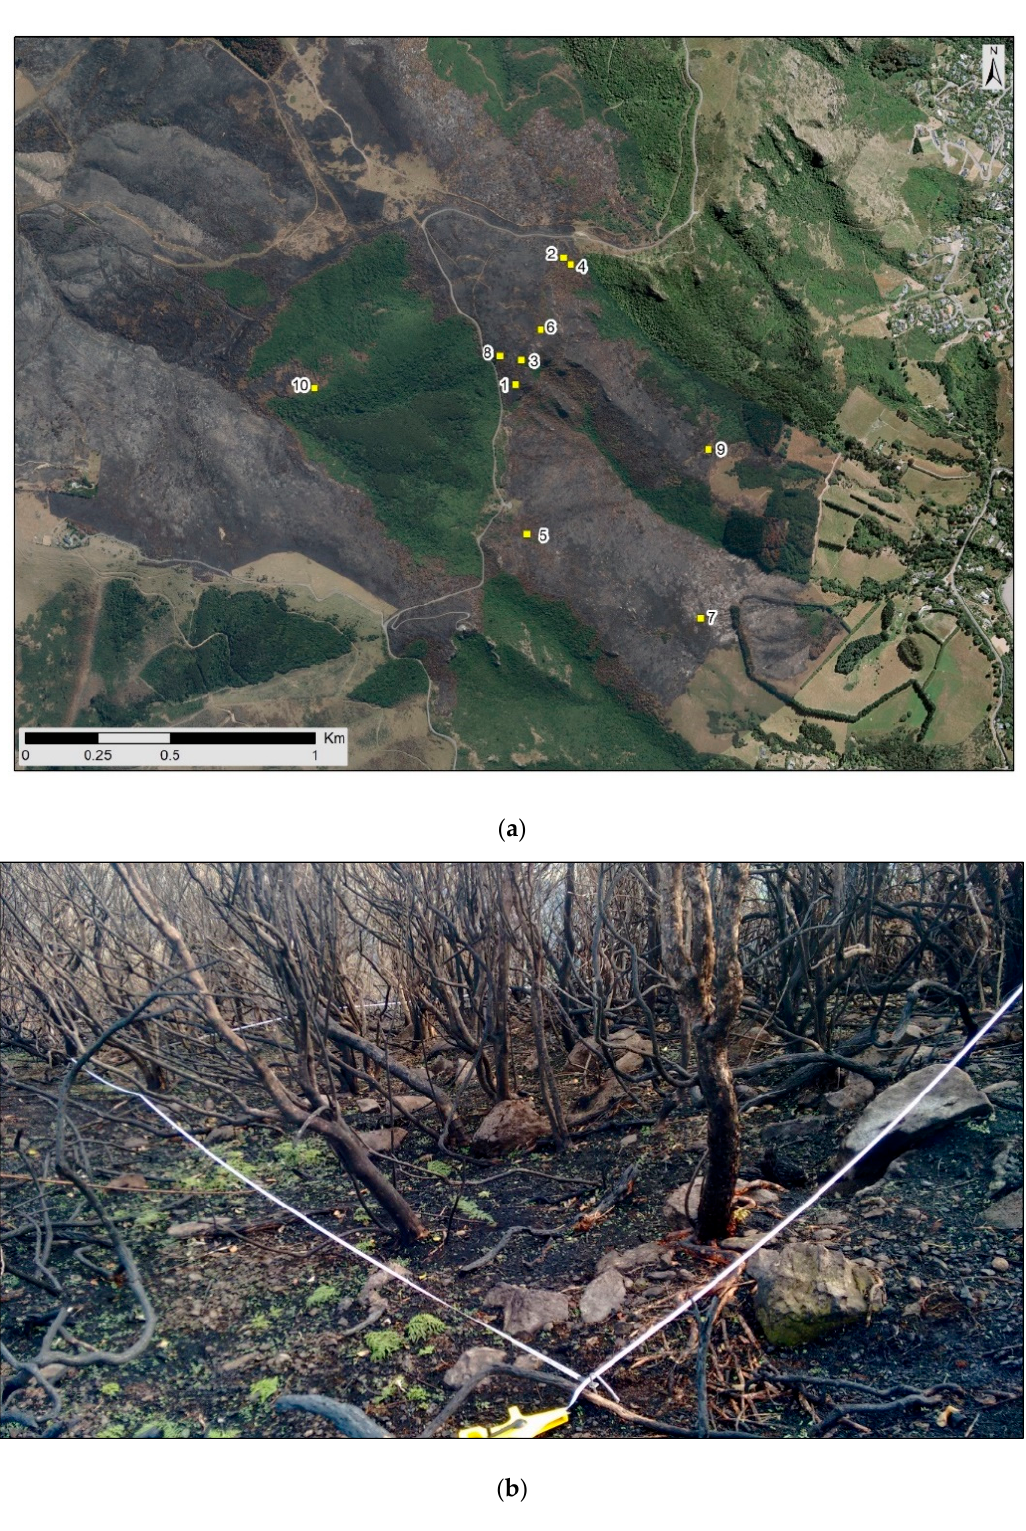
Figure A1. Location of the sampling plots in the burned landscape ( a ). Photograph of one of the sampling plots ( b ).